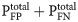
Consensus-based clustering applied to replicated tetrode recordings with ground truth.a. Tetrode recordings obtained from rat hippocampal CA1 with simultaneous intracellular recording from one cell in the vicinity of the electrode were spatially replicated 8 times with a time shift. This resulted in artificial 32-channel recordings with 8 ground-truth clusters. These recordings were processed as if they had been obtained from 32-channel linear electrode array with 20-μm spacing between recording sites. b. Left, Dendrogram obtained by hierarchical clustering with the Single Link method over the distance matrix defined from the pairwise probability of spike misclassification between final clusters (Pmis, see Methods). Right, Pairwise probability of spike misclassification between final clusters. c. Whitened spatiotemporal waveforms of 5 of the final clusters identified by consensus-based clustering. The cluster templates were defined as the average waveform (black). Cluster #5 and #6 were identified as matching the intracellularly recorded cell #3 and #8 respectively. The estimated probability of misclassified spikes (PFPtotal+PFNtotal, see Methods) is shown below each cluster. Almost all replicated groundtruth spikes were correctly identified (FPrate + FNrate ≤ 1%).